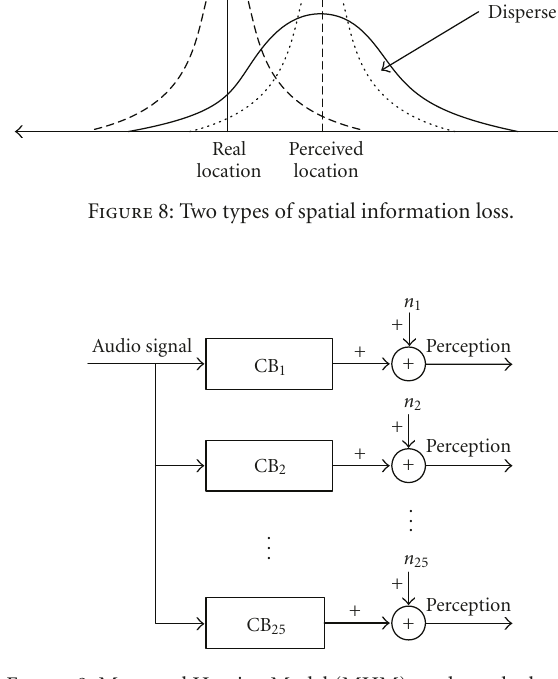
Figure 9: Monaural Hearing Model (MHM) used to calculate